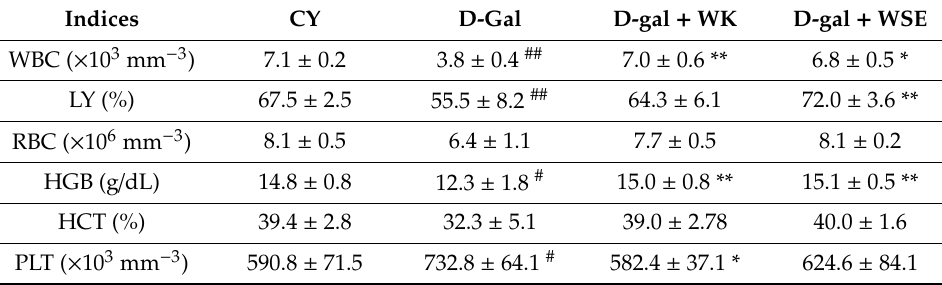
Table 3. Analysis of hematological indices in D-gal-induced aging